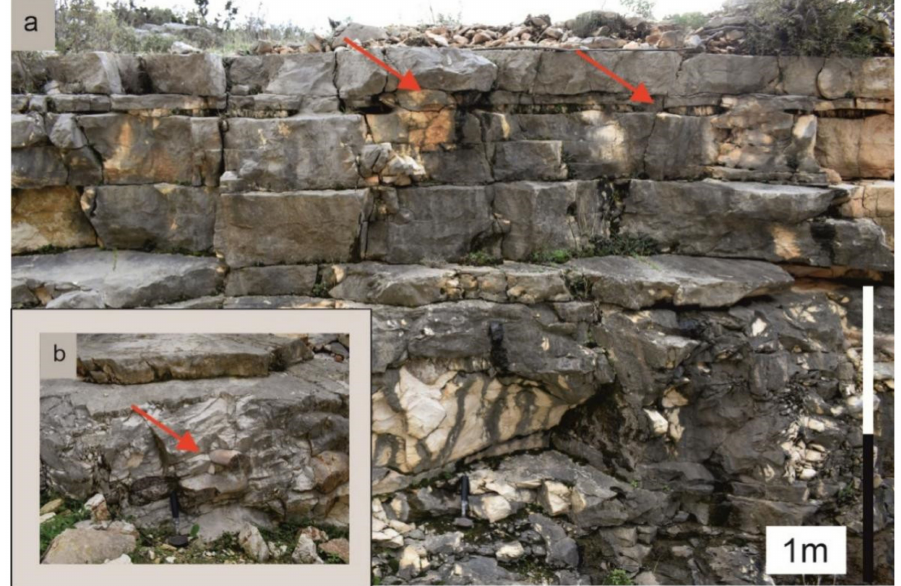
Figure 8. ( a ) General view of the outcrop of the Maastrichtian micritic limestones where nodules and thin layers of chert (red arrow) locally occur, ( b ) chert Nodules (red